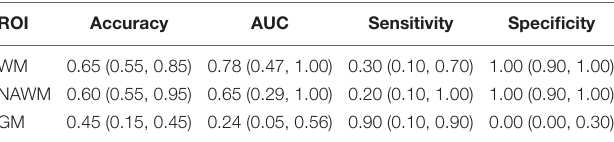
TABLE 6 | Logistic regression model performances on external validation dataset showing the median (90% CI) for each tissue type for T1w images. ROI Accuracy AUC Sensitivity Specificity